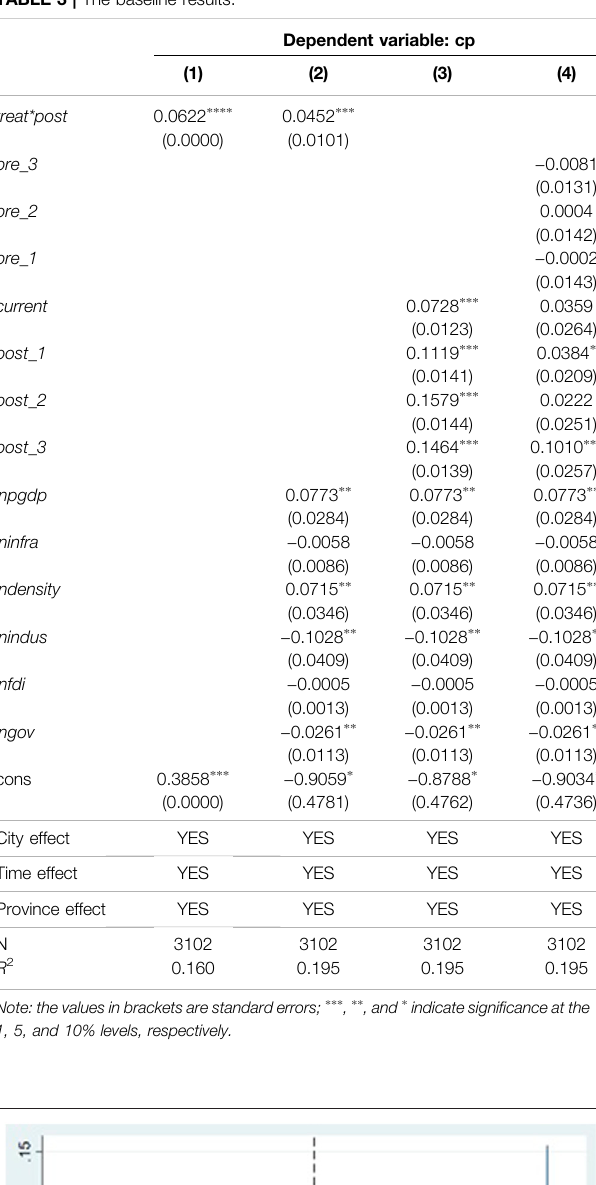
TABLE 3 | The baseline results.